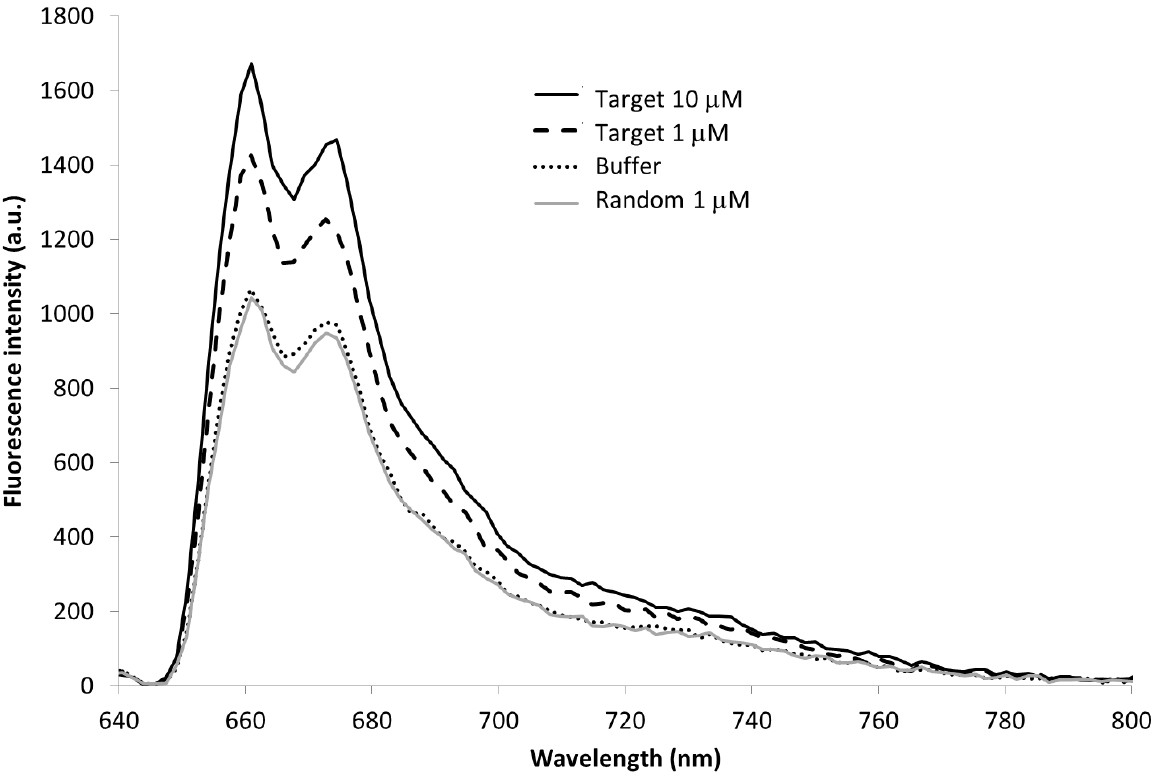
Figure 6. MB immobilized onto the nanotip, characterization in presence of the target (1 µM and 10 µM) and of the random sequence (1 µM). λ ex 635 nm, exposure time 1